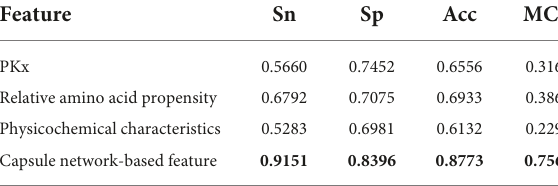
TABLE 4 Performance comparison across different features by